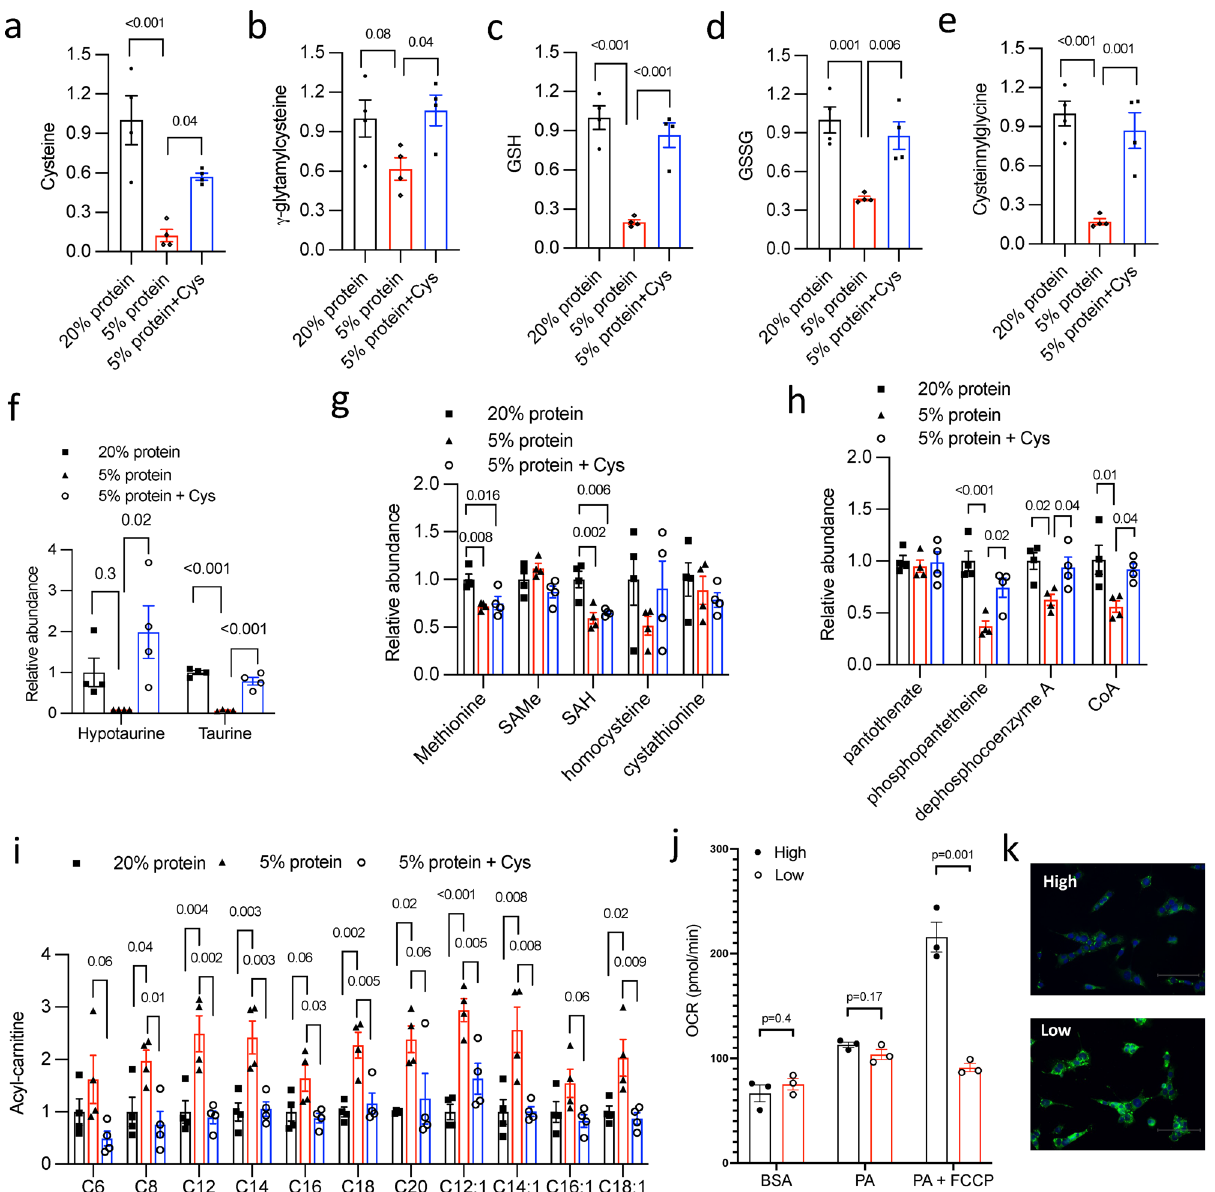
Fig. 6 | Hepatic cysteine availability is a key determinant of hepatic CoA synthesis and maximal fatty acid oxidation capacity. a – i Male 10 weeks old C57BL/6JmicewerefedisocaloricWesterndietcontaining20%protein,5%protein or 5%proteinwith addedcystine (Cys) for 6 weeks. Mice wereeuthanizedafter6h fast. Liver tissues were used for metabolomics analysis ( n =4). Relative abundance of liver metabolites is shown with control arbitrarily set as 1. All results are mean±SEM.A p value<0.05isconsideredstatisticallysigni fi cant(One-wayANOVA andposthocDunnetttest).GSHreducedglutathione,SAMsS-adenosylmethionine, SAH S-adenosylhomocysteine, CoA coenzyme A. j . AML12 cells were cultured in medium containing 200 μ M (High) or 20 μ M (Low) methionine and cystine